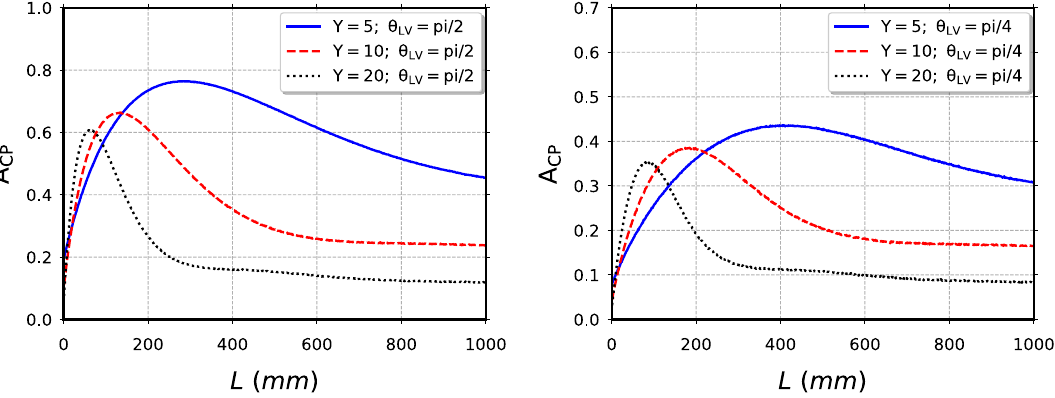
Fig. 6 CP asymmetry as a function of the maximal displaced vertex length ( L ) for M N = 2 . 0 GeV and | B μ N | 2 = | B τ N | 2 = 10 − 5 . Left Panel: θ = π/ 2. Right panel: θ = π/ 4 LV LV